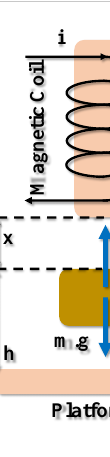
Figure 1. Model of the